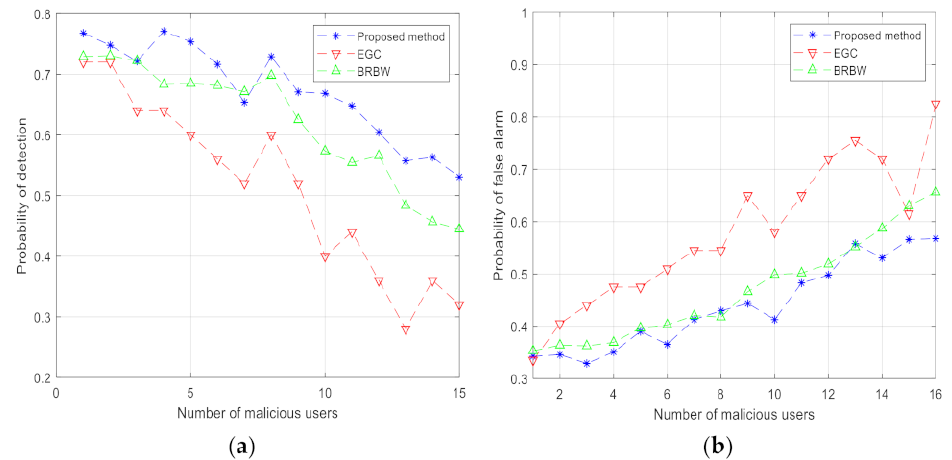
Figure 11. ( a ) The change of detection probability with the increase of malicious nodes for three different algorithms; ( b ) the change of false alarm probability with the increase of malicious nodes for three different